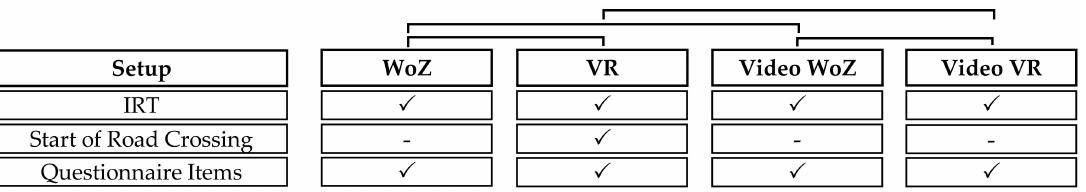
Figure 5. Comparison of the di ff erent setups.